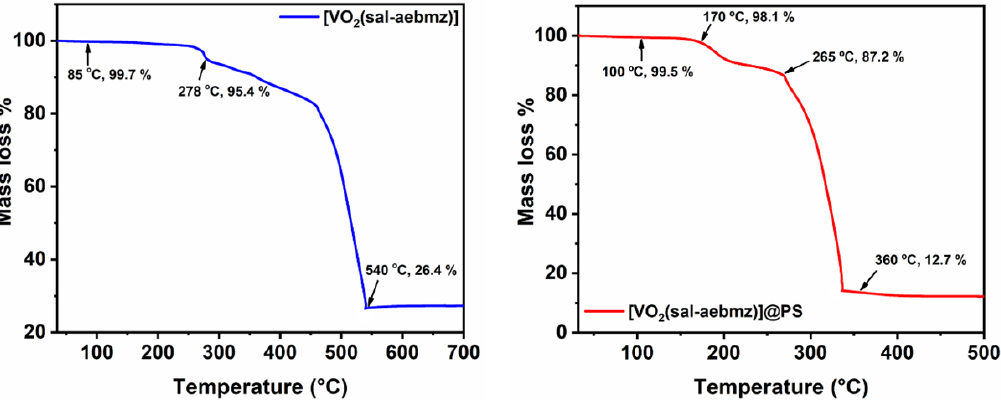
Figure 1. TGA profiles of [V V O 2 (sal-aebmz)] ( 1 ) and heterogeneous catalyst [V V O 2 (sal-aebmz)]@PS ( 2 ).